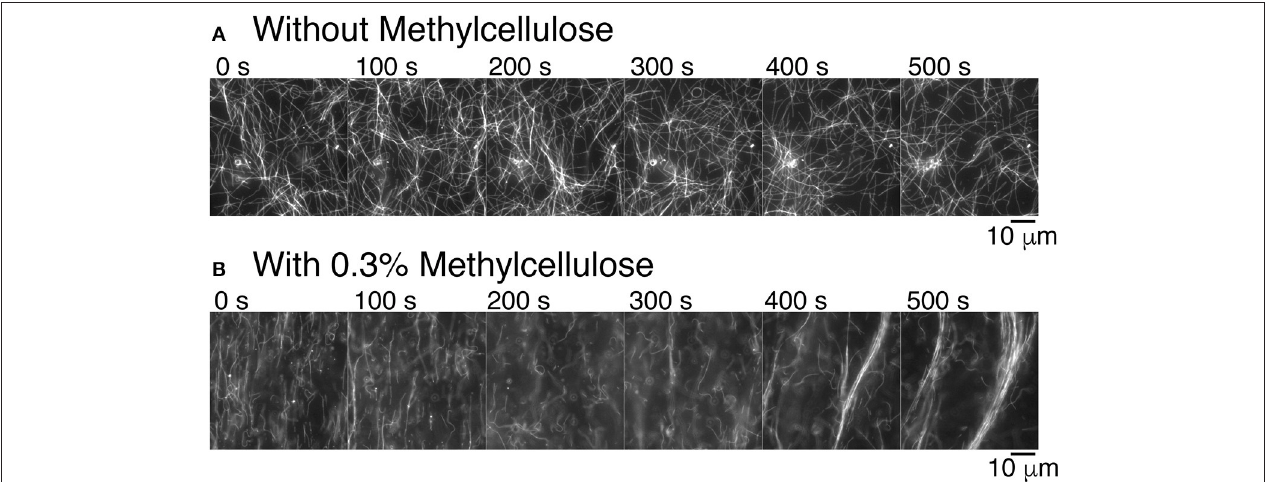
FIGURE 3 | Methylcellulose increases microtubule interactions. (A) Time series of gliding microtubules in a chamber with kinesin-1 motors only without methylcellulose. Microtubules do not exhibit long-range interaction. Microtubules do create small loops. Time between frames is 100s. (B) Time series of gliding microtubules in a chamber with kinesin motors and 0.3% methylcellulose, as used in our composite assays. Microtubules begin in a nematic phase, which is aligned and transition to a polar phase. Time between frames is 100s. For all images, the scale bar is 10 µ